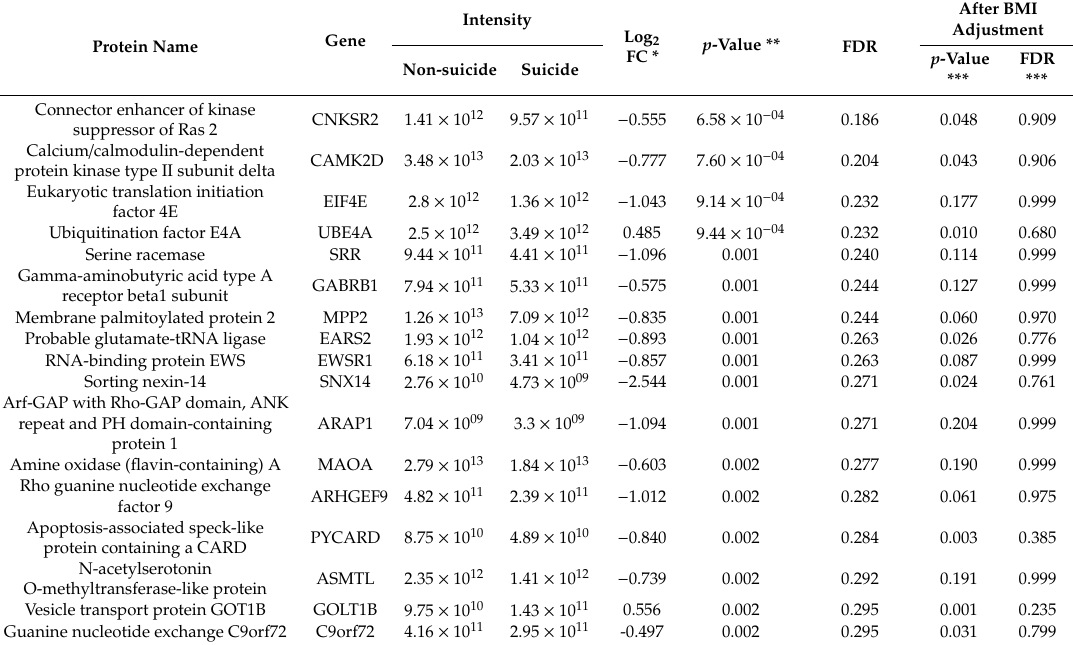
Figure 1. Proteomic profile identified by mass spectrometry-based untargeted proteomics. Proteins differentially expressed in the dorsolateral prefrontal cortex (DLPFC) of five individuals who died by suicide and five individuals who died by other causes (non- suicide) by having a false discovery rate (FDR) corrected p -values (Benjamini–Hochberg– Yekutieli procedure) < 0.3, absolute Log 2 fold change (FC) > 0.4, and no missing values in any of the samples. (A) Volcano plot showing the downregulated proteins (blue), upregulated (red) and proteins that did not meet criteria (gray). (B) Heat map reflecting the expression values of proteins of interest from the non-suicide and suicide cases. Samples of each group are arranged in columns, proteins in rows. Blue shades show decreased expression and red shades show increased expression. 3.3. Pathway Analysis The top 33 proteins with an FDR < 0.3 and Log 2 FC >|0.4| were selected for pathway analysis by IPA and the described settings were applied. Five IPA canonical pathways were significantly enriched at p < 0.05 (Figure 2). These pathways were related to the following neurotransmitters and other nervous system signaling: GABA receptor signaling ( p < 0.001), serotonin receptor signaling ( p = 0.003), melatonin signaling ( p = 0.008), CREB signaling in neurons ( p = 0.009), and dopamine receptor signaling ( p = 0.009). The three proteins that hit in the GABA receptor signaling pathway included KCNQ3 and GABRB1, both were downregulated, and ADCY5 was upregulated.